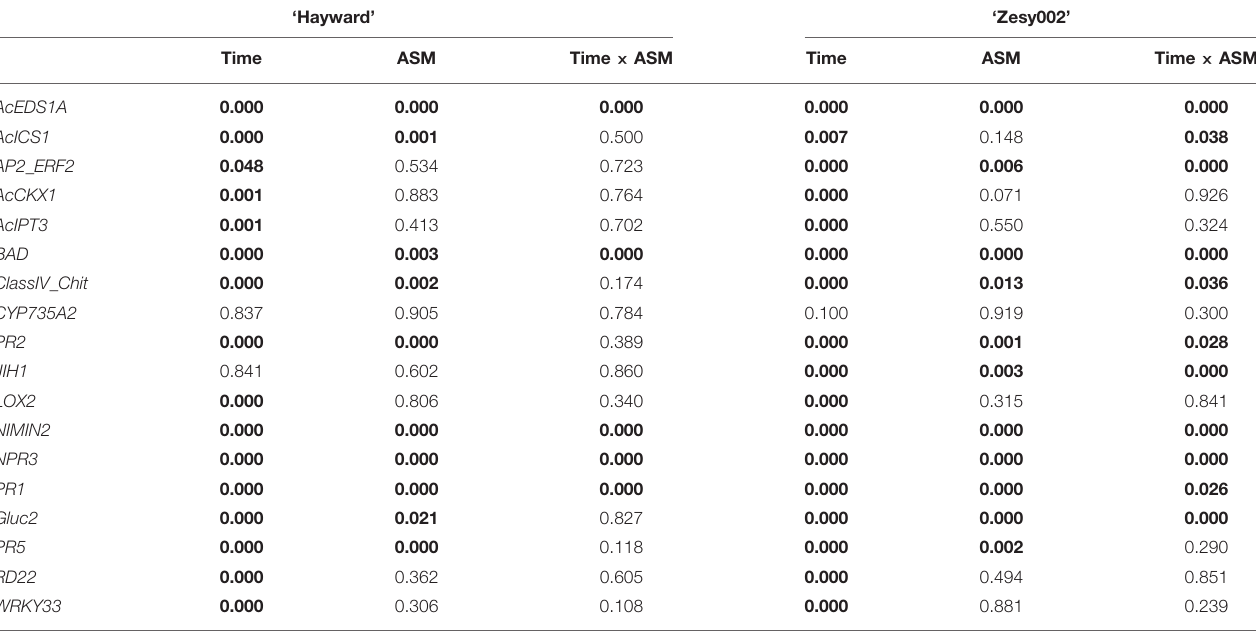
TABLE 6 | P -values from the statistical analyses to determine the effect of Actigard (ASM) application and time on gene expression in leaves of Actinidia chinensis var. deliciosa ‘Hayward’ and A. chinensis var. chinensis ‘Zesy002’ kiwifruit vines in spring in 2018.